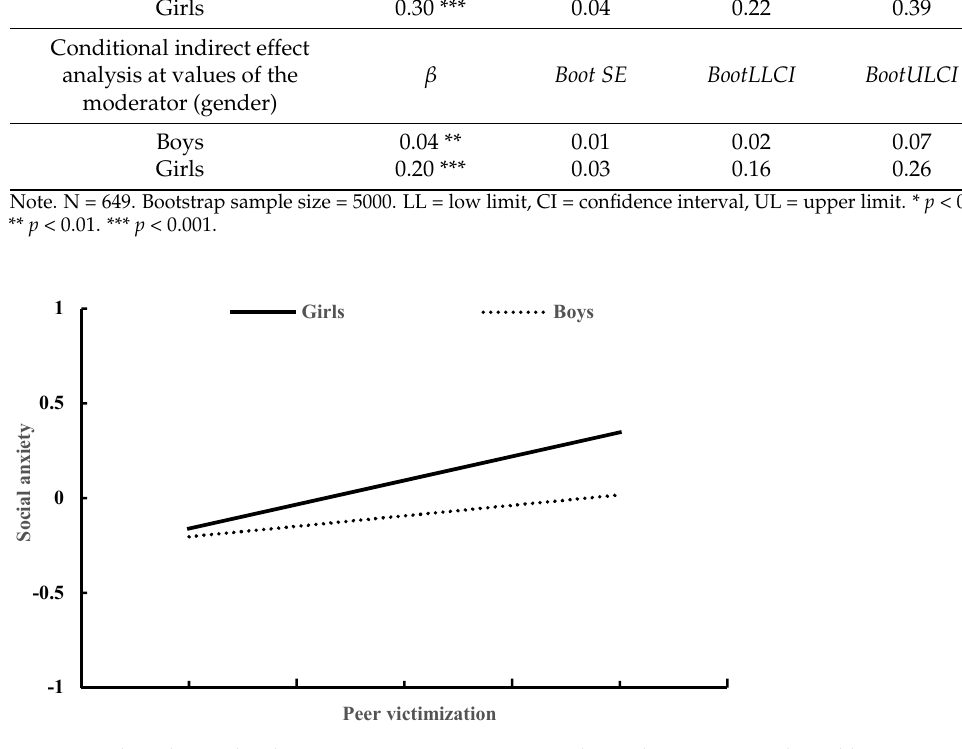
Figure 2. The relationship between peer victimization and social anxiety in girls and boys.